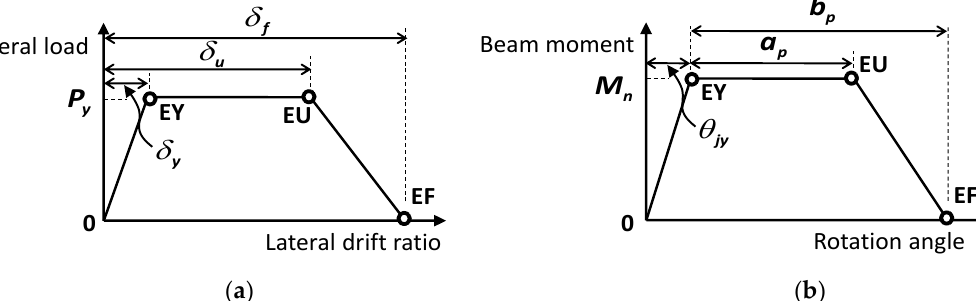
Figure 4. Load–displacement relationship of plastic hinge model: ( a ) lateral load–drift relationship of beam–column joint; ( b ) moment–rotation relationship of plastic hinge.